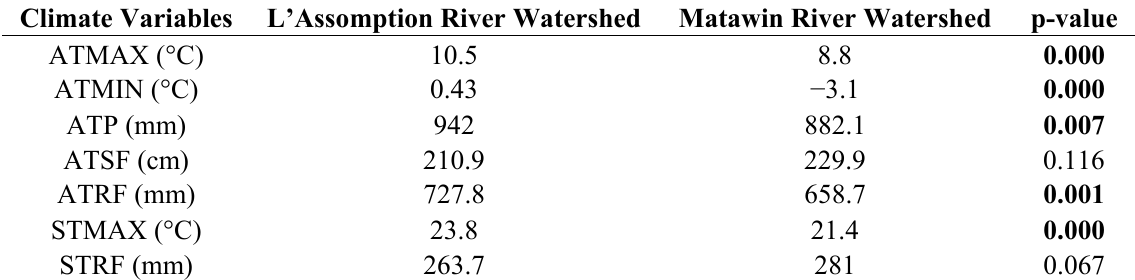
Table 1. Comparison of mean values of climate variables in the L’Assomption (agricultural) and Matawin (forested) watersheds using the paired t test.